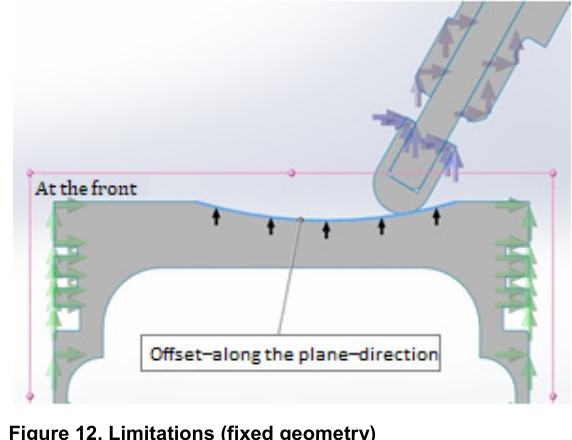
Figure 11. The dependence of vibration during the comp– ression stroke on the crankshaft speed for a VAZ 21083 engine